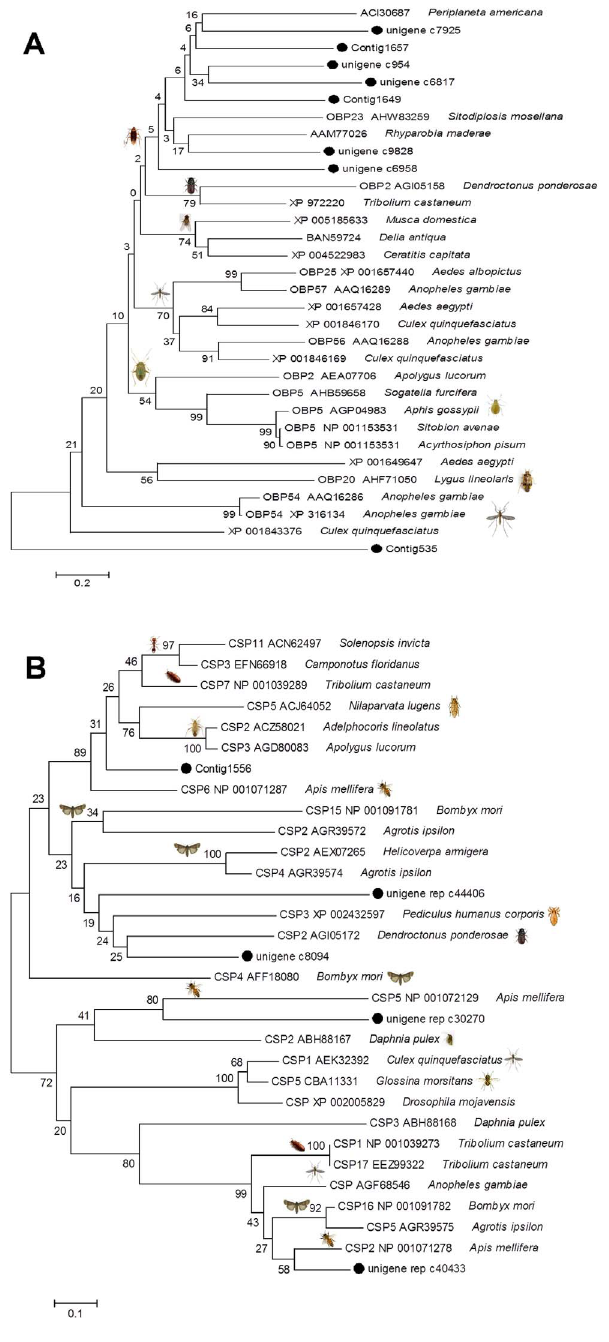
Figure 5. Phylogeny of the OBPs (A) and CSPs (B) from the German cockroach and their homologs. The unrooted consensus trees with 1000 bootstrap replicates are generated in MEGA6 [39] using the neighbor-joining method. The tree is drawn to scale, with branch lengths in the same units as those of the evolutionary distances used to infer the phylogenetic tree. All positions containing gaps and missing data are eliminated. GenBank accession numbers and species names of the sequences used here are shown in the phylogenetic trees. German N ) are in bolds. cockroach OBPs and CSPs (marked by